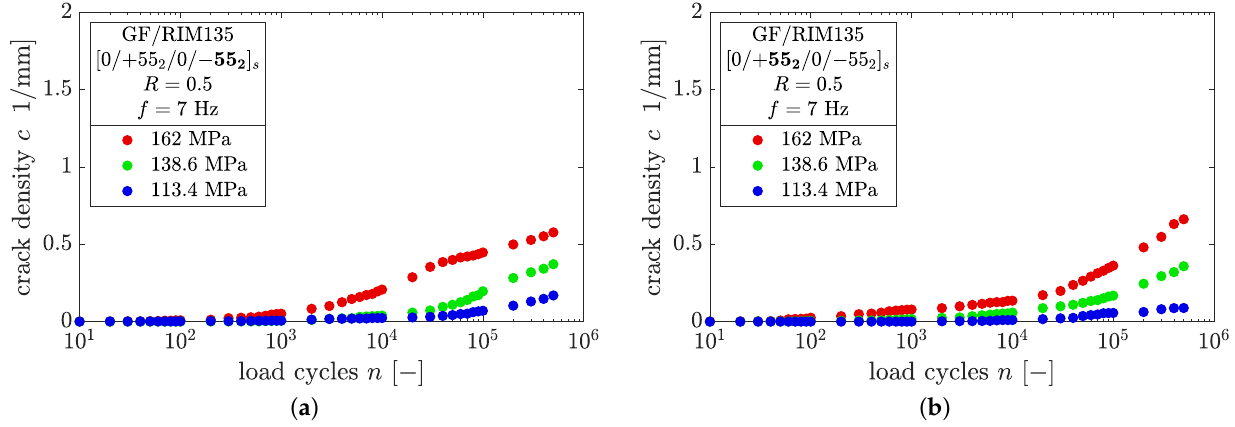
Figure A6. Results of the crack counting procedure for [ 0/ + 55 2 /0/ − 55 2 ] s -laminates for ( a ) thick and ( b ) thin layers at R =